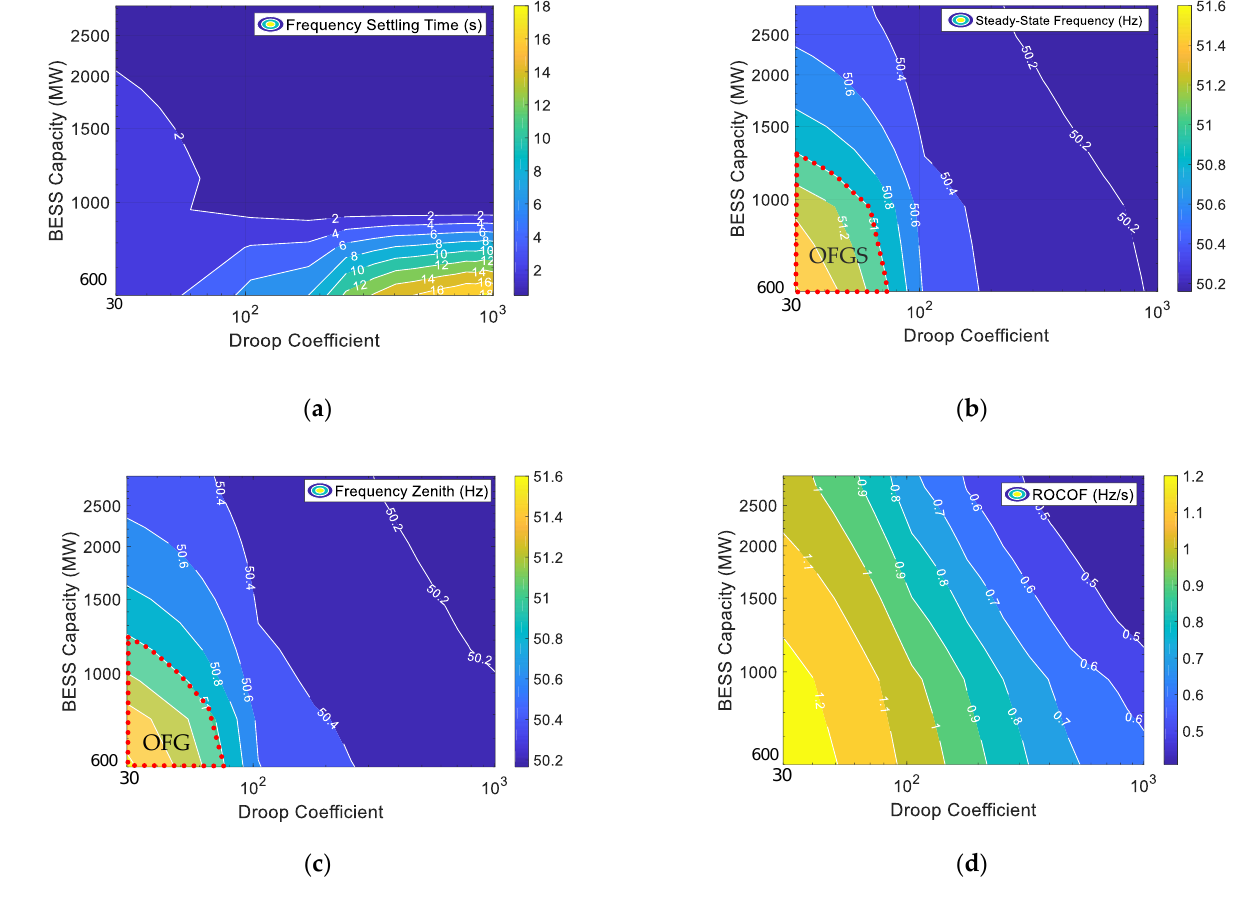
Figure 15. ( a ) Frequency settling time; ( b ) steady-state frequency; ( c ) frequency zenith; and ( d ) ROCOF for using different capacities and droop coefficients of BESS, when only BESS participates in PFC support.